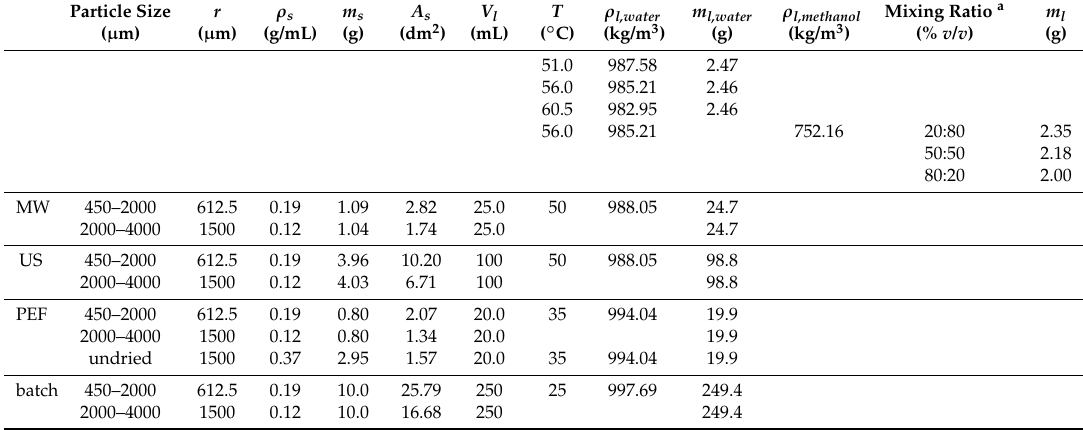
Table 1. Red vine leaves properties and extraction